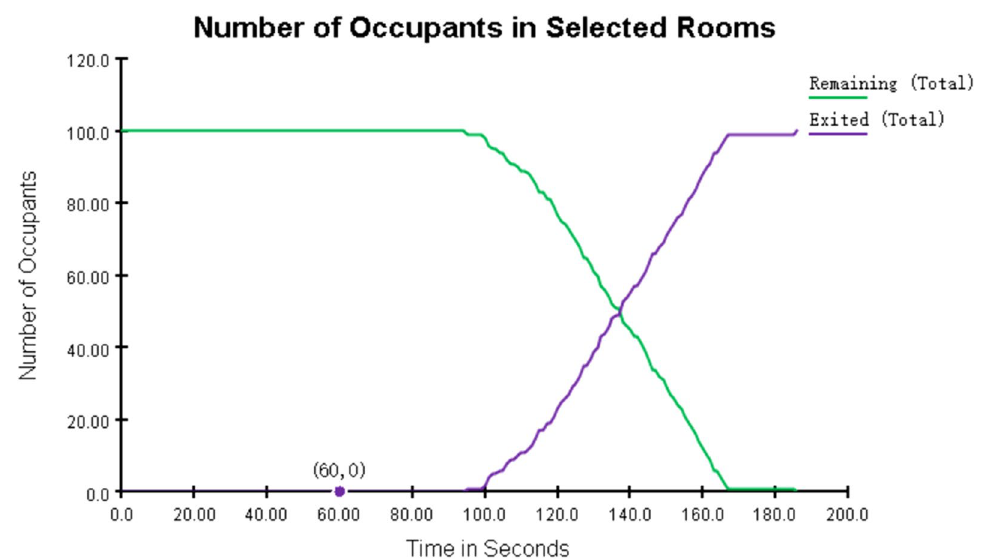
Figure 17. Evacuation time-number